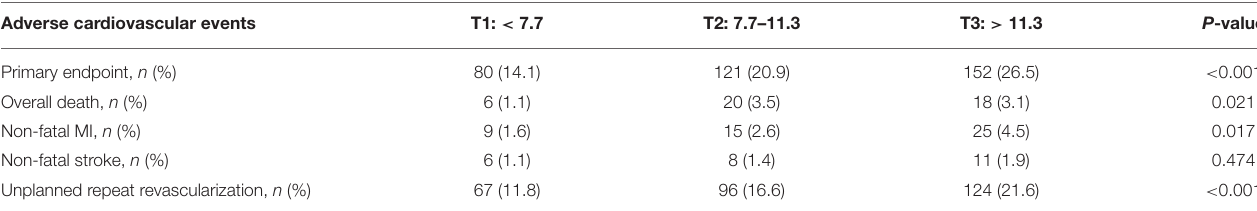
Frontiers in Cardiovascular Medicine |